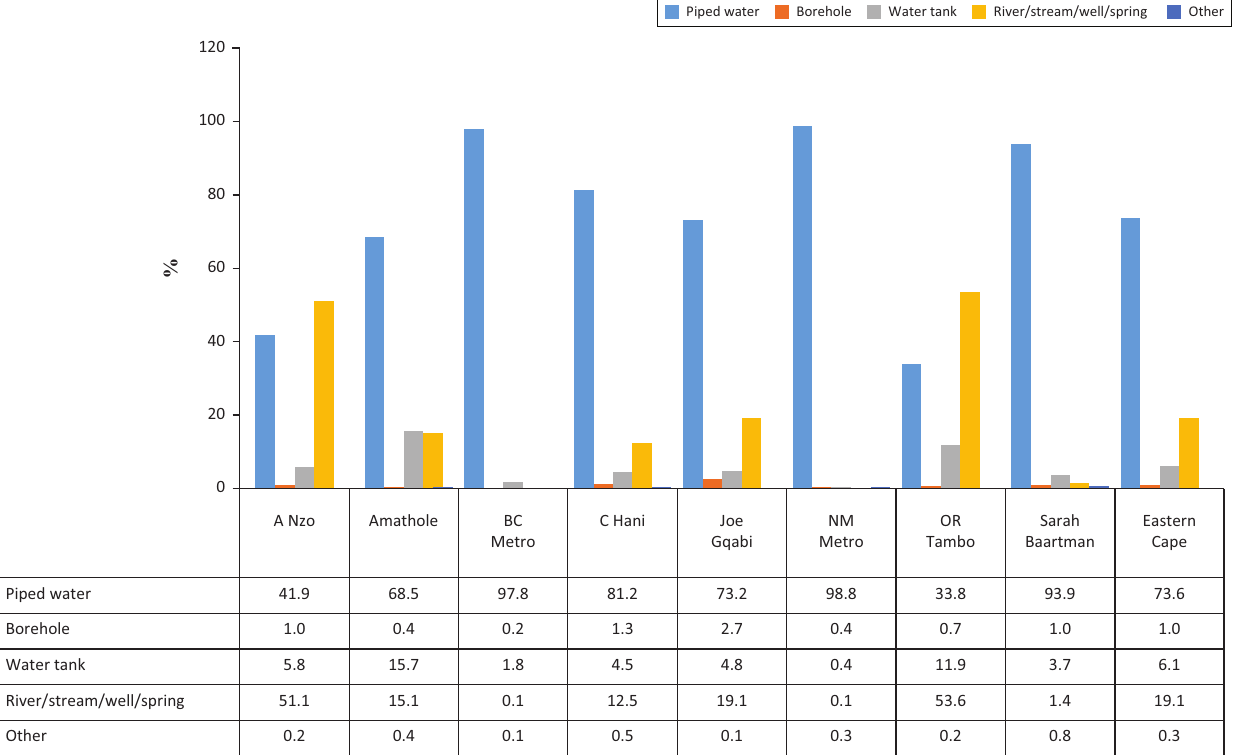
FIG URE 4: Water sources for use by households in the Eastern Cape province, 2016.